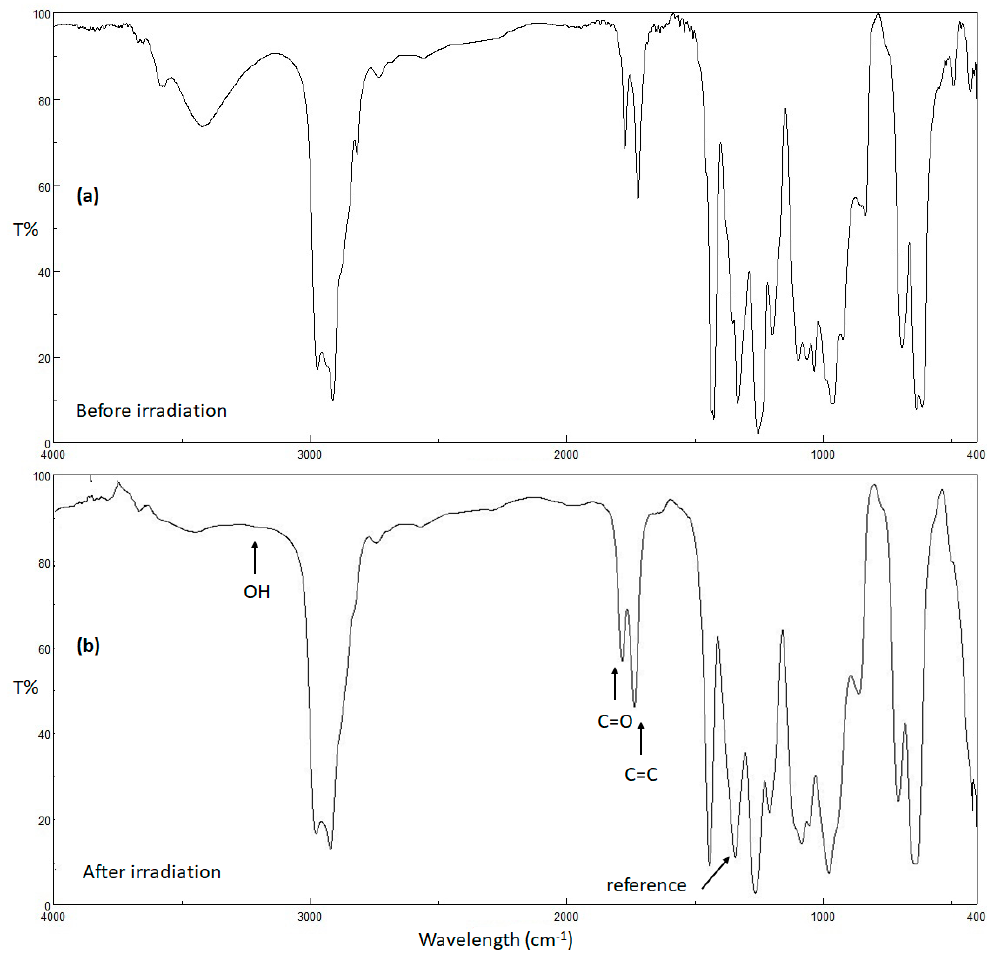
/ 3 blend ( a ) before and ( b ) after irradiation.